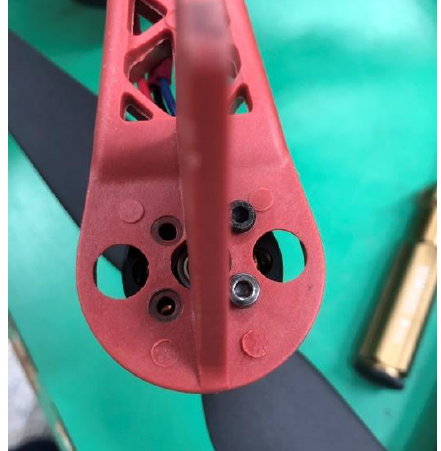
Figure 3. Motor mount asymmetrically